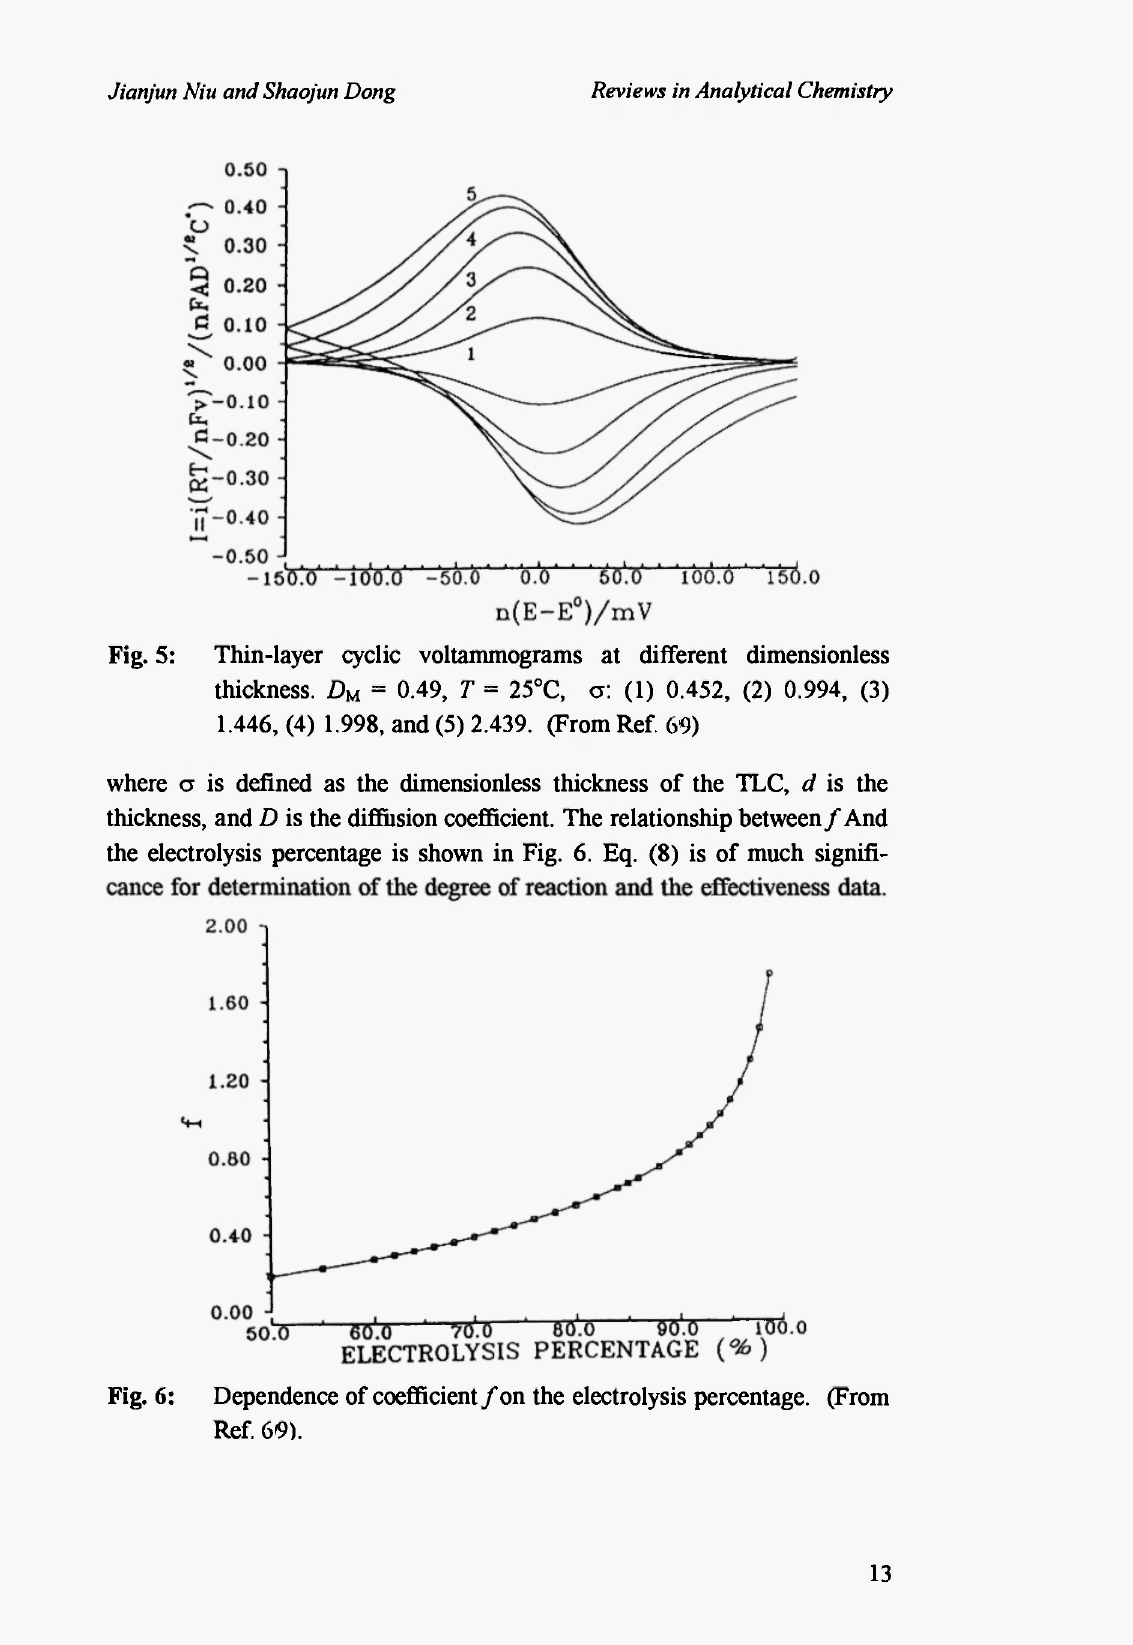
Fig. 6: Dependence of coefficient / on the electrolysis percentage. (From Ref. 69).